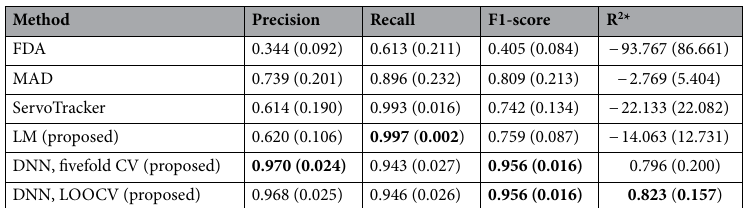
Table 2. Edi peak detection performance. Values are presented as mean (standard deviation). *Coefficient of determination of respiratory rate. Significant values are in [bold]. FDA first derivative with adaptive threshold, MAD moving average with dynamic threshold, LM local maximum, DNN deep neural network with local maximum, CV cross validation, LOOCV leave-one-out